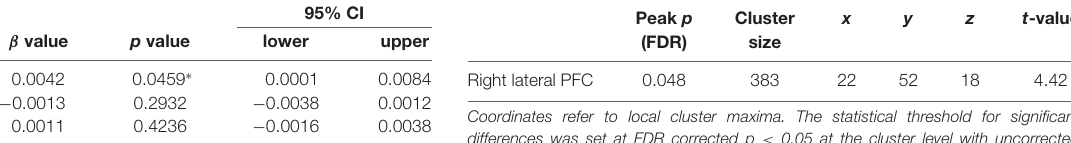
TABLE 5 | Significant brain regions seeding the right striatum between the groups (Control > Nurse) in the resting state fMRI 95% CI